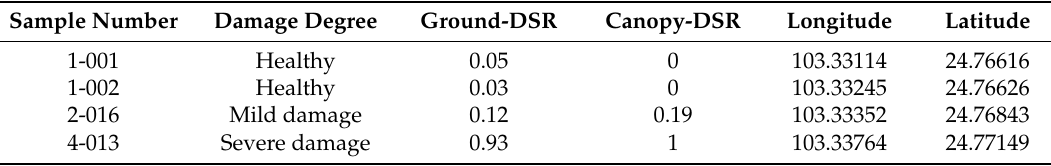
Table 4. Comparison table for Canopy-DSR and